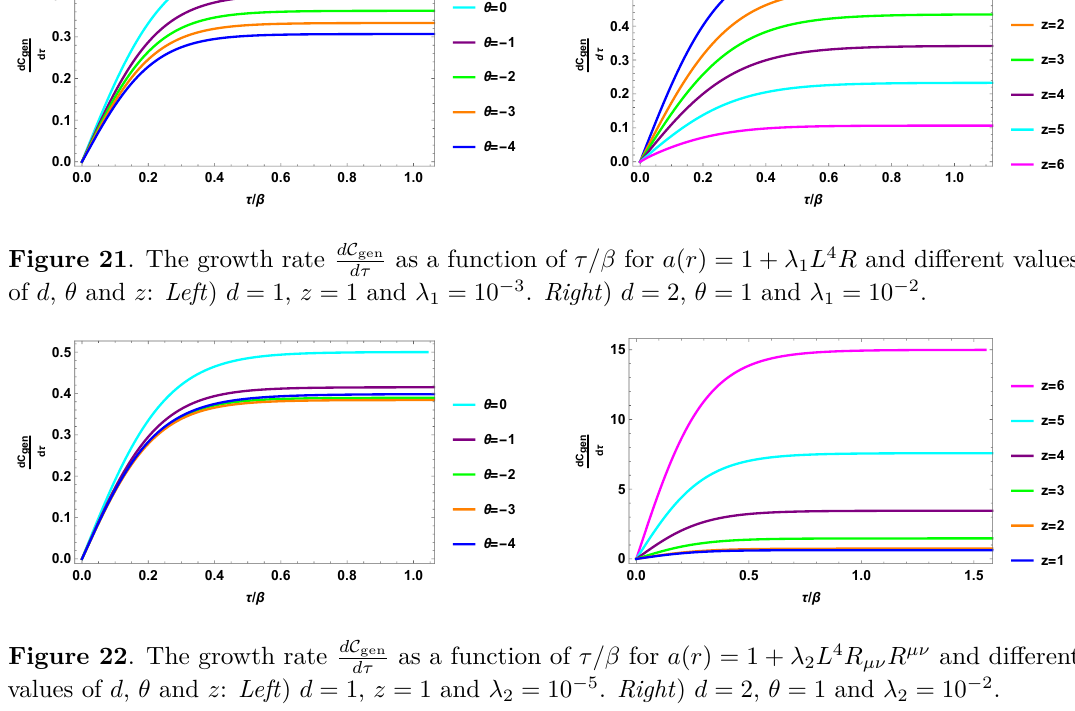
Figure 22 . The growth rate d C gen values of d , θ and z : Left ) d = 1 , z = 1 and λ